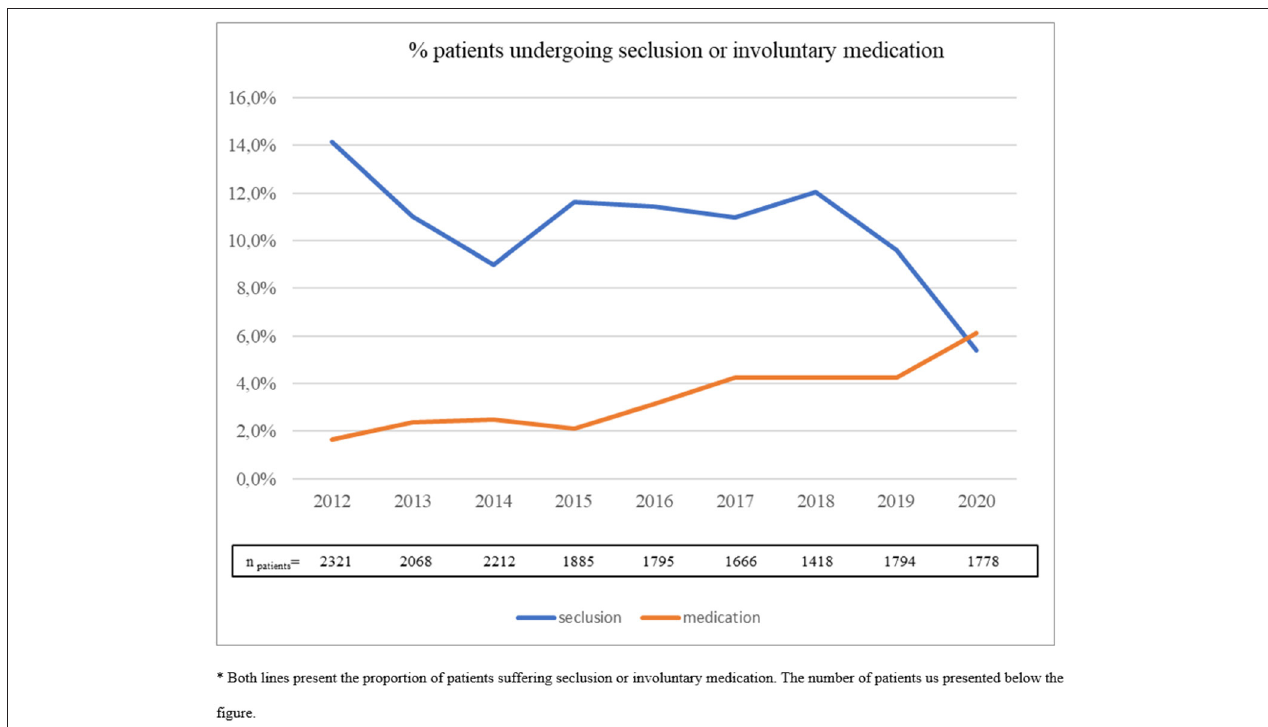
FIGURE 2 | Percentage patients undergoing seclusion or involuntary medication. *Both lines present the proportion of patients suffering seclusion or involuntary medication. The number of patients us presented in the